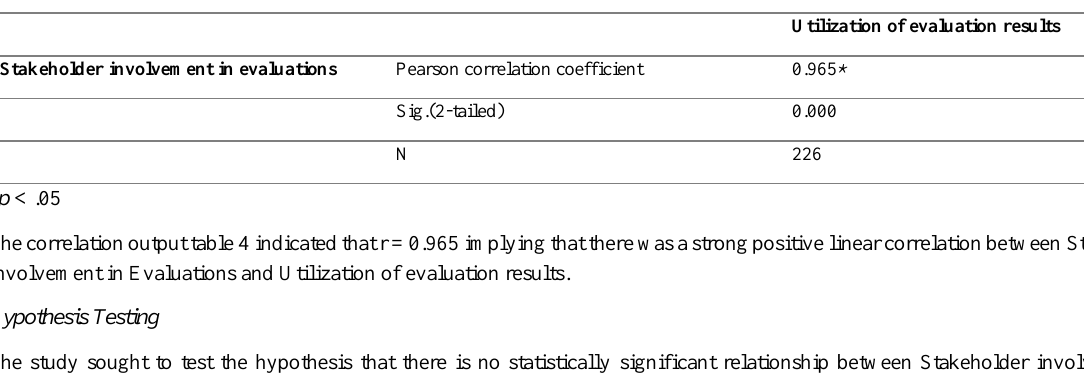
Table 4: Correlation between Stakeholder involvements in evaluations on Utilization of evaluation